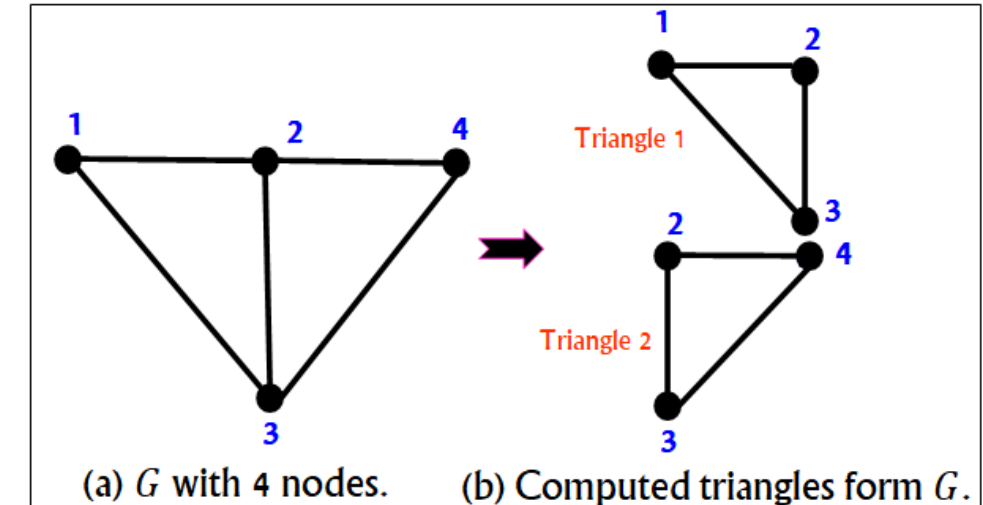
Figure 17. Overview of triangle computations from G by privacy-aware graph computing